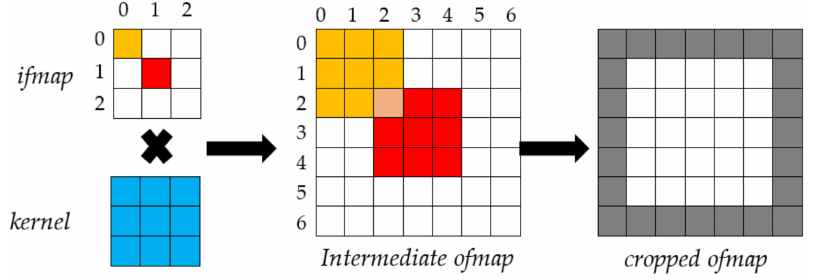
Figure 1. The adopted deconvolution approach.